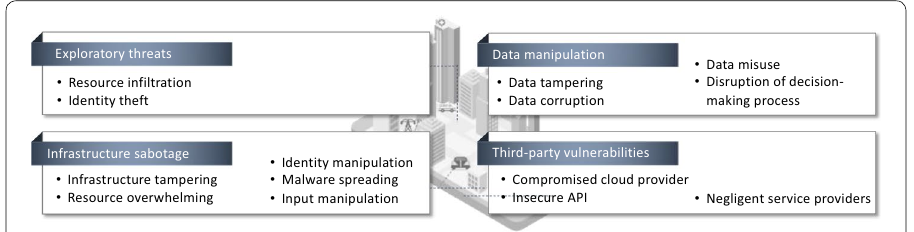
Fig. 3 Threat landscape of smart